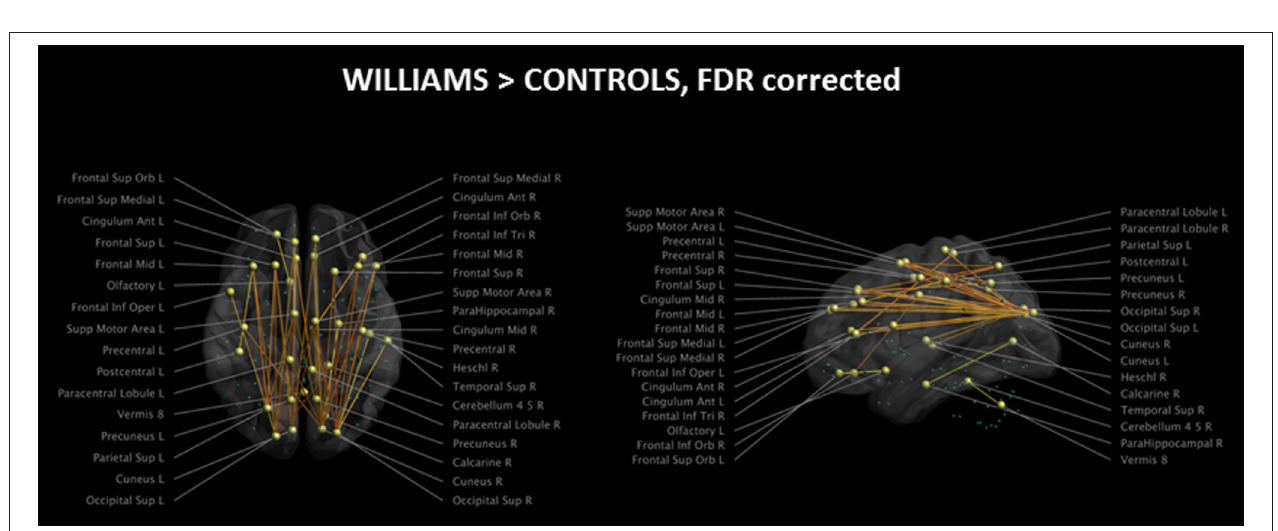
FIGURE 2 | Impaired structural connectivity in WS patients compared to HCs (left: axial view; right: sagittal view). Most of the impaired connections originate from parieto-occipital regions and are directed to frontal areas. On the axial view, it is evident that very few transcallosal connections are impaired. Green spheres represent nodes with no anomalies in structural connectivity. Significance level is set at p < 0.05 corrected for multiple comparisons.